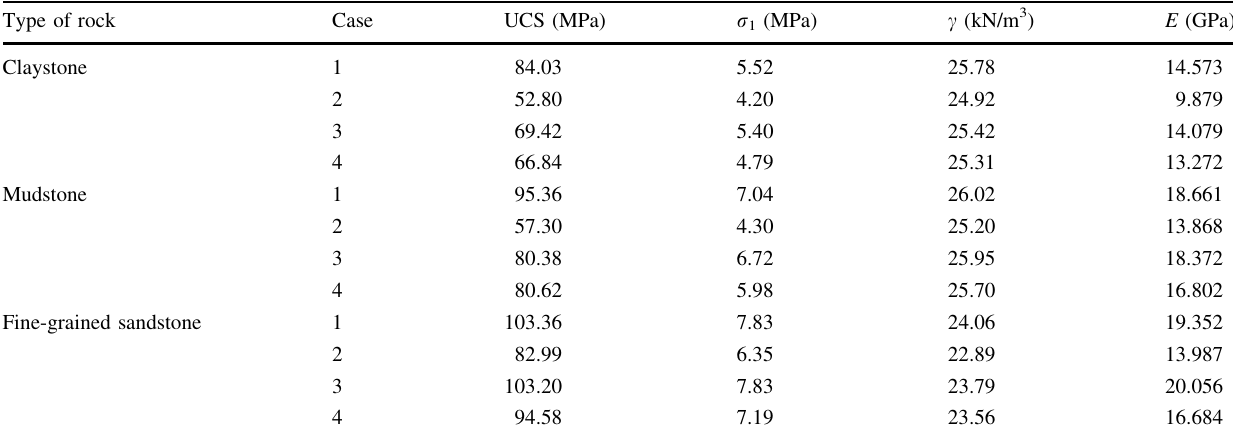
Table 1 Geomechanical parameters used in numerical analysis Type of rock